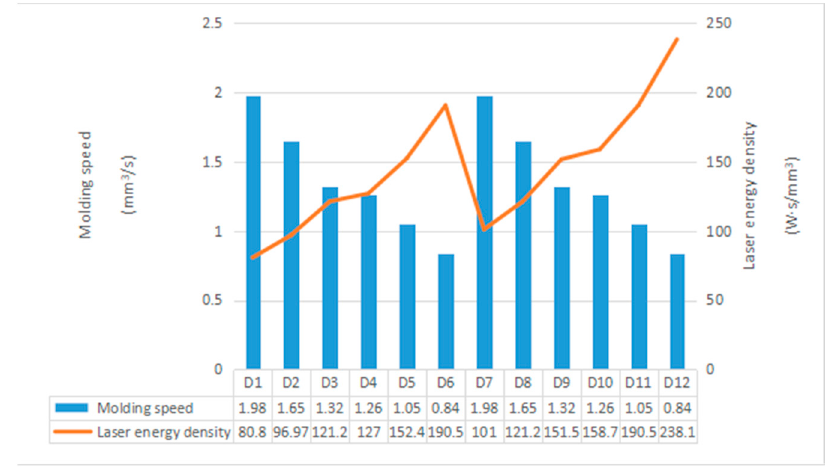
Figure 13. The calculation results of molding speed and laser energy density.